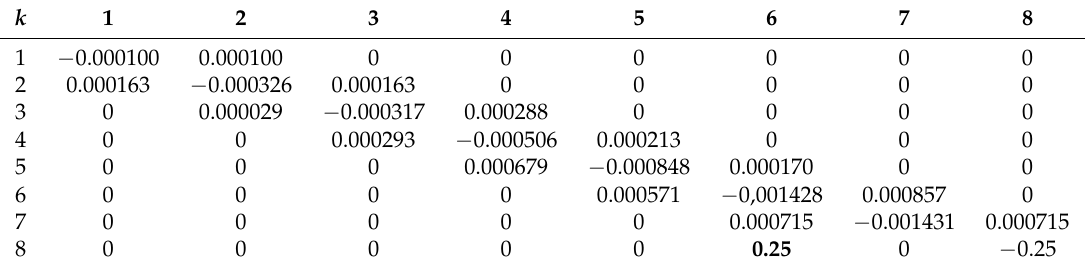
Table 2. Generator